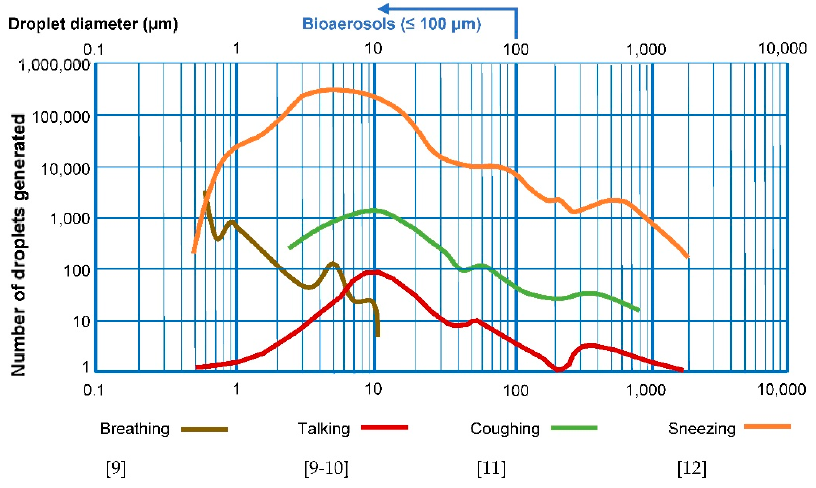
Figure 3. Droplets emitted according to the type of